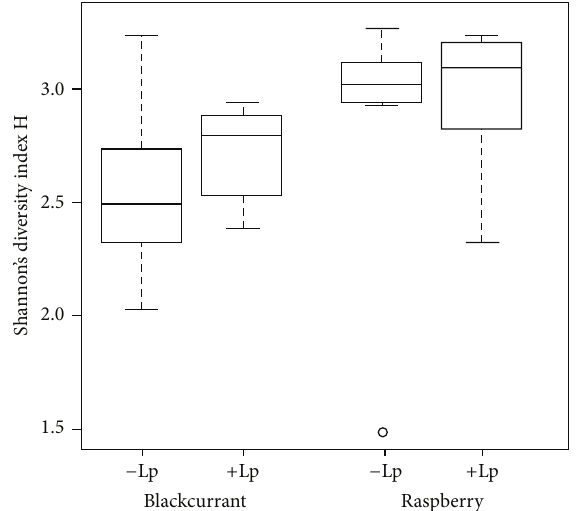
Figure4:Shannon’sdiversityindexHofthecaecalmicrofloraofrats fed blackcurrant and raspberry, with the same diets supplemented with L. plantarum